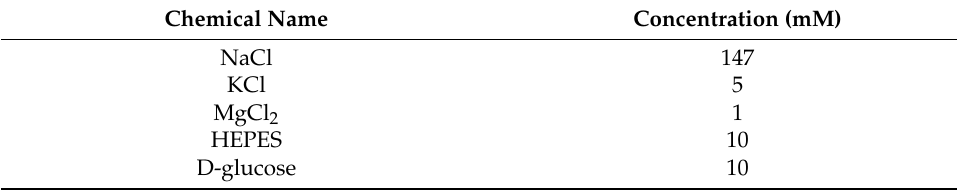
Table 3. E1 Standard Extracellular Solution (SES).